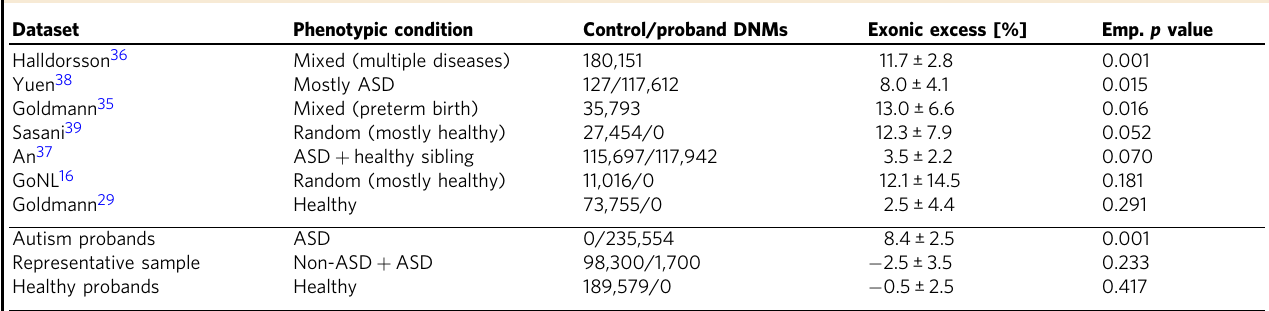
Table 1 Properties of analyzed DNM datasets including excess in exonic burden.